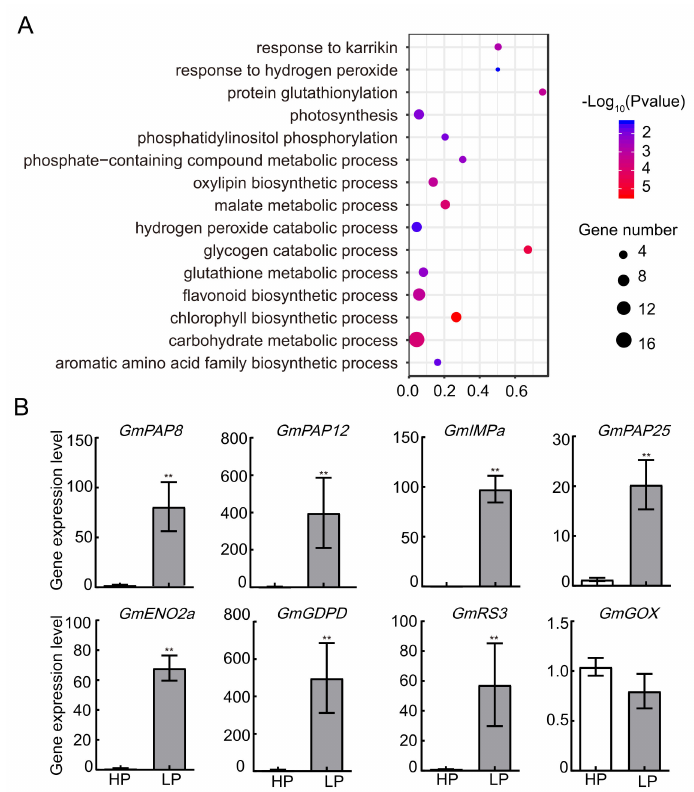
Figure 3. GO and qPCR analysis of LP-induced proteins. ( A ) Functional categorization of LP-induced proteins based on biological processes. Bubble colors represent the corrected P-value, and the bubble sizes indicate the number of genes. ( B ) The qPCR analysis of LP-increased genes identified in LFQ analysis. Error bars: SEM. Asterisks indicate significant difference by Student t-tests:, ** p <